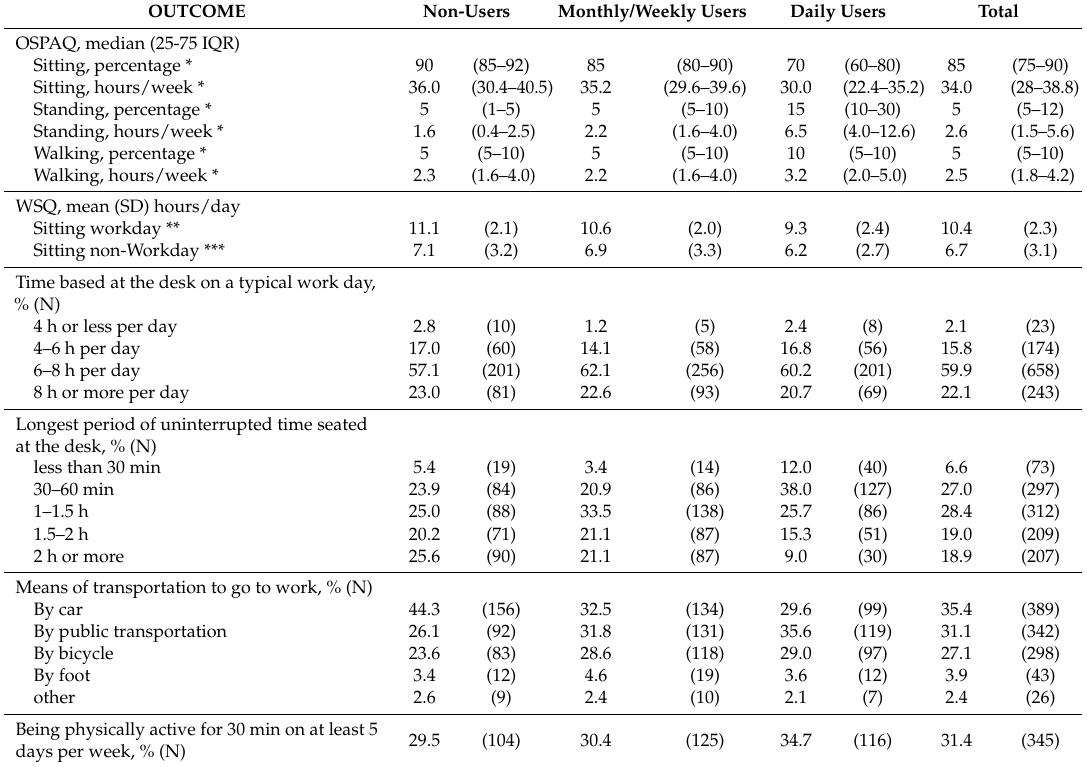
Table 3. OSPAQ, Occupational Sitting and Physical Activity Questionnaire; WSQ, Workforce Sitting Questionnaire. Occupational (bouts of) sitting, means of transportation to work, meeting guidelines for being physical active. OUTCOME Non-Users Monthly/Weekly Users Daily Users Total OSPAQ, median (25-75 IQR) Sitting, percentage